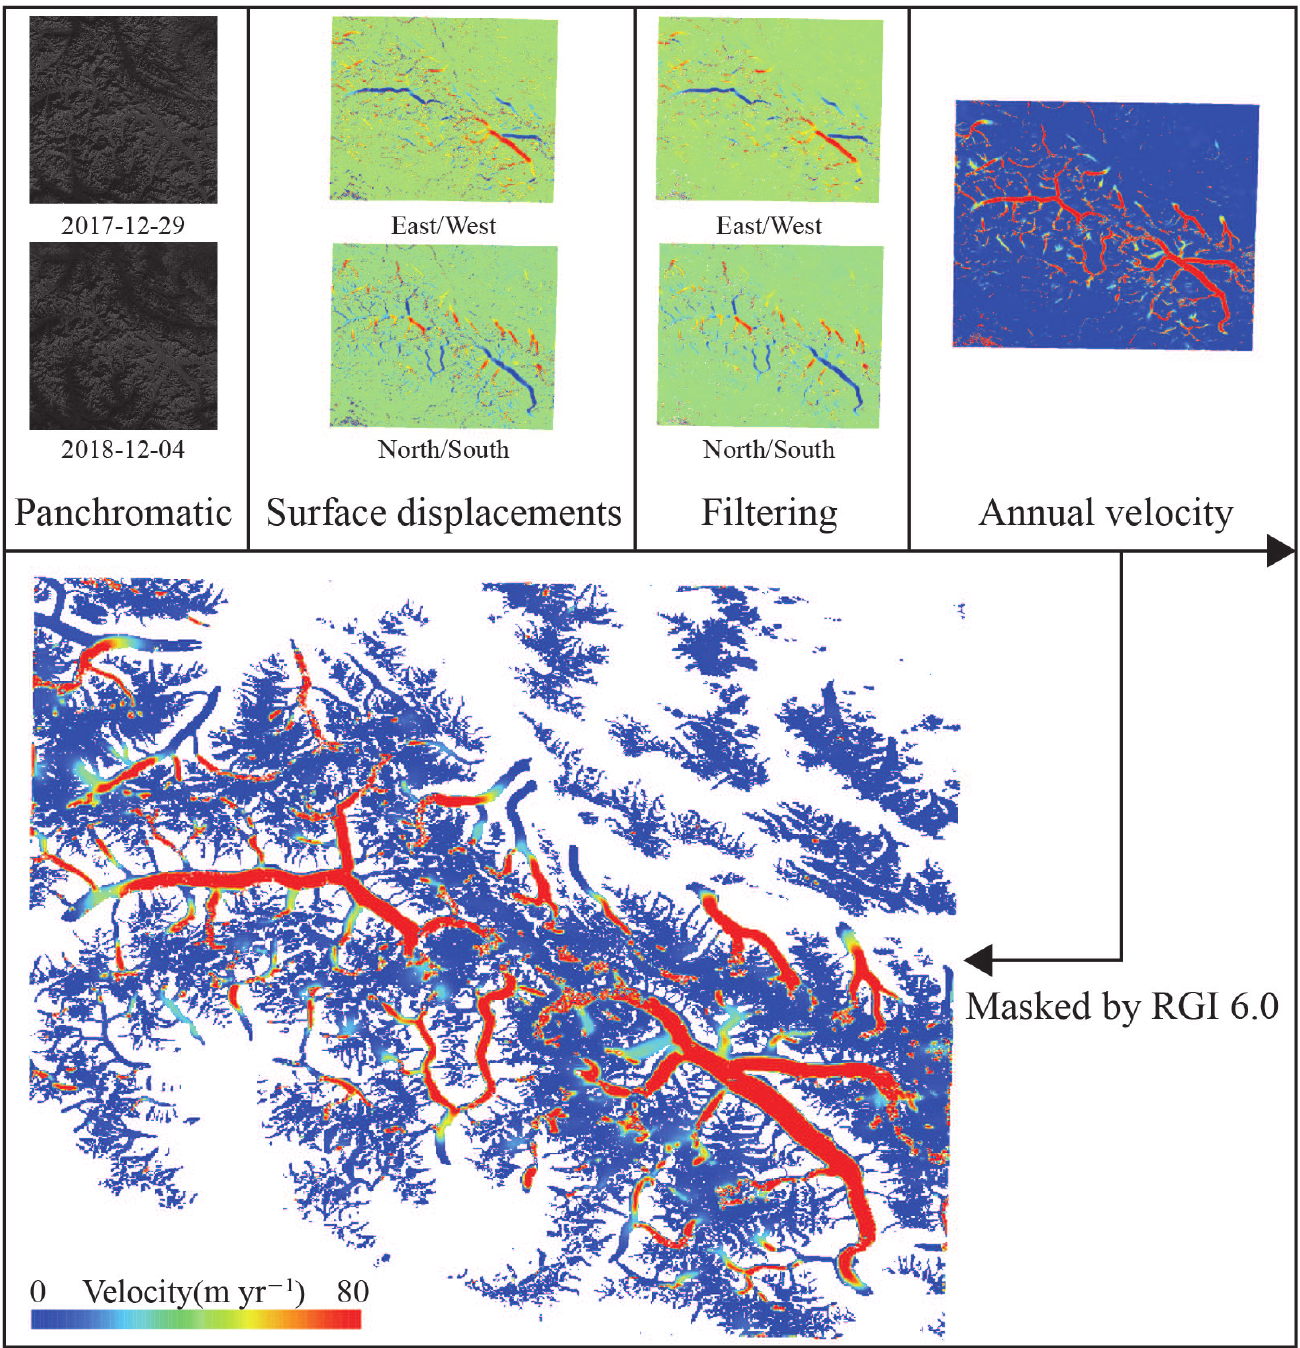
Figure 2. Deriving glacier surface velocity using optical correlation. The Sentinel-2 optical data were provided by the European Space Agency (ESA). See Figure 1 for